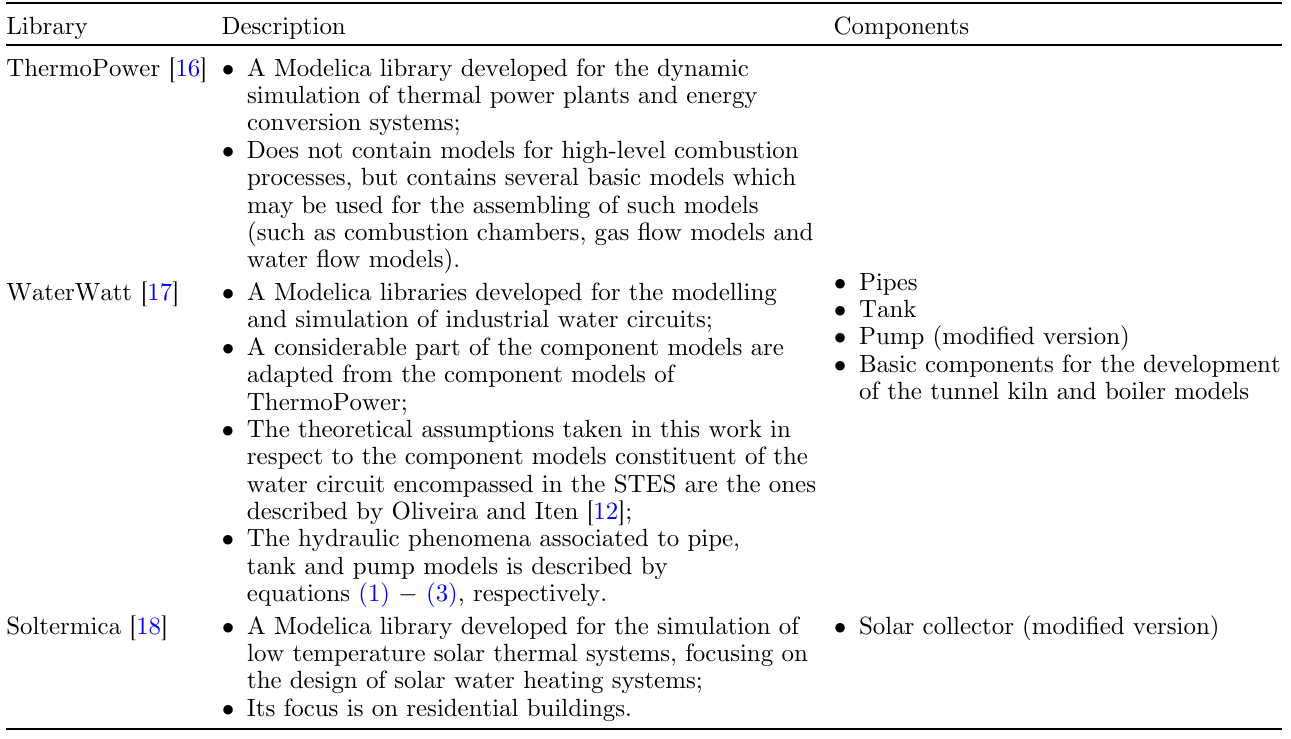
Table 2. Description of Modelica libraries used to assemble the STES model. Library